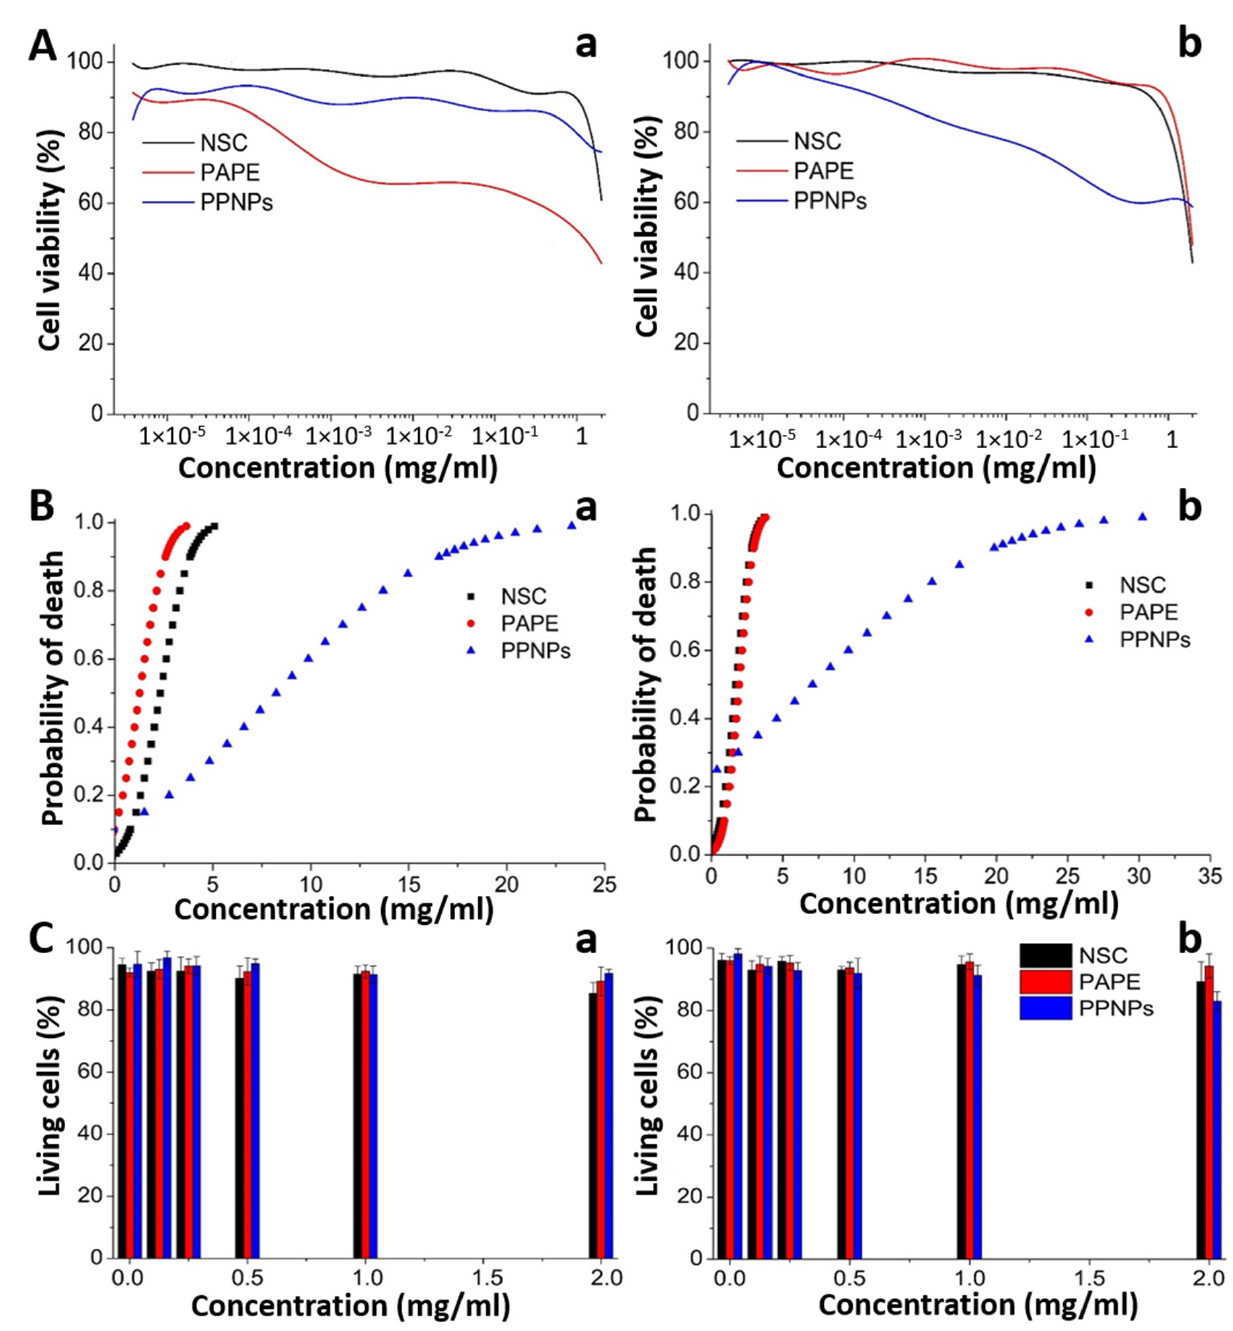
Figure 4. Concentration response curve for cytotoxicity assay ( A ), death probabilities ( B ), and percentage of living cells with DMEM culture medium as a negative control ( p < 0.001) ( C ) of exposed RL14 cardiomyocytes ( a ) and NiH3T3 fibroblasts ( b ) performed after 24 h using NSC, PAPESE, and PPNP treatments,